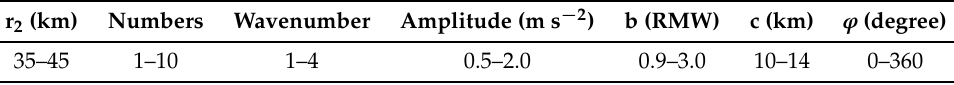
Table 1. Restrictions for each parameter to generate random